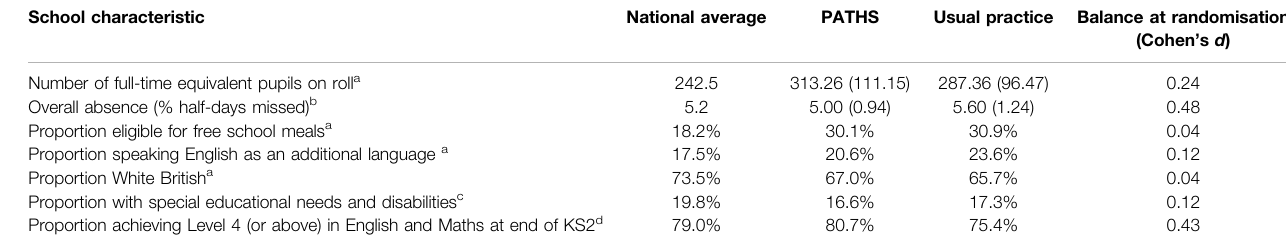
TABLE 1 | School sample characteristics and national average